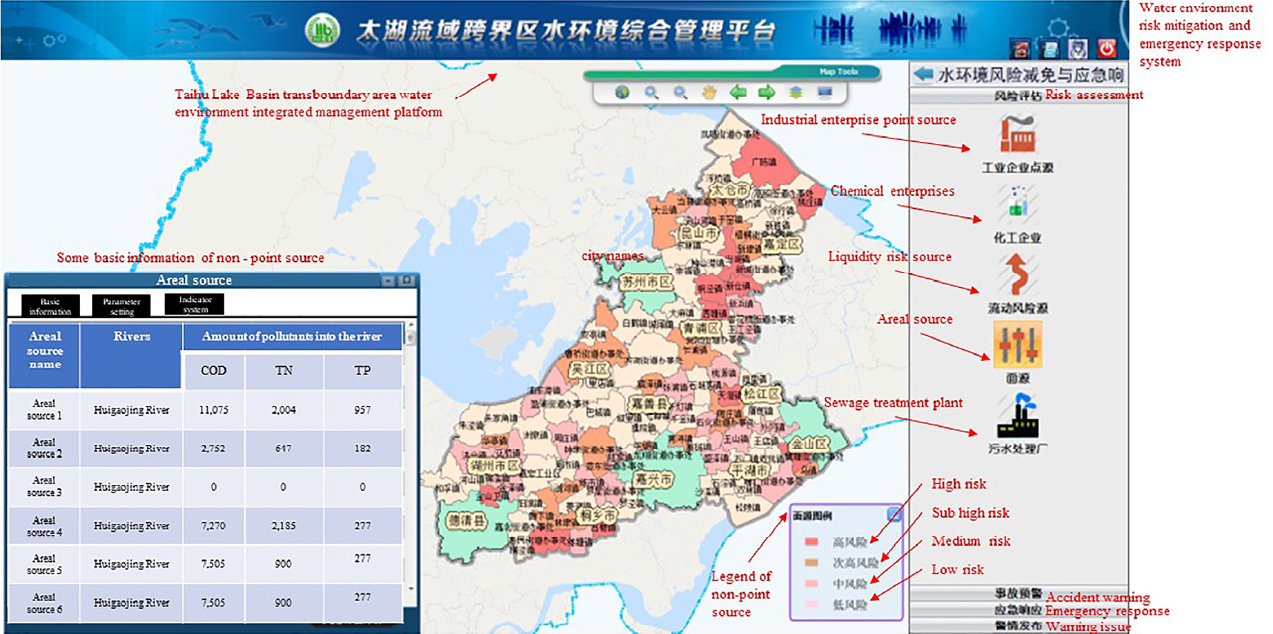
Figure 8. Non-point source risk assessment results.